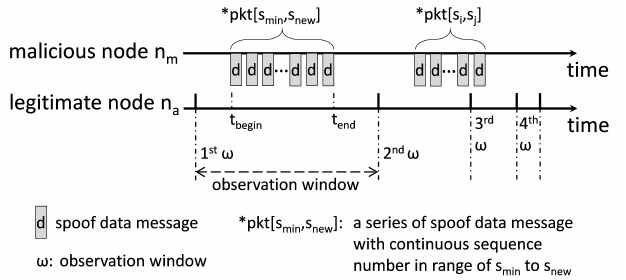
Figure 4. Example of adaptively adjusted observation window ω based on the detected multicasting